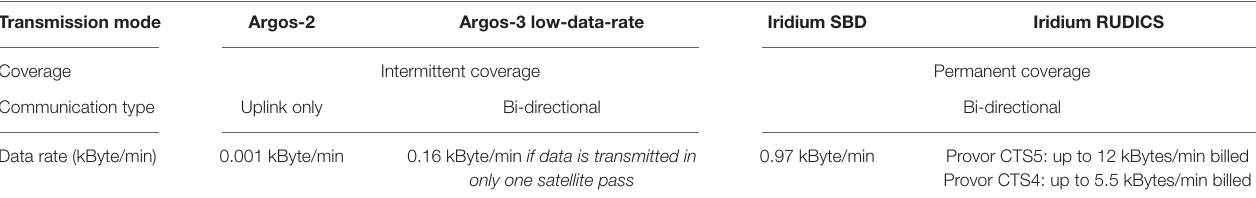
FIGURE 12 | Survival rate of the main Argo profiling floats. After 1,000 days at sea, 98% of the SOLO 2, 96% of the Arvor, 93% of the NAVIS_EBR and S2A, and 89% of the APEX are still in operation at sea. The float-sample criteria comprised their status (active, operational, or closed), deployment date (since January 1, 2016), and cycle period (240 h or 10 days). Source: www.jcommops.org, September 23, 2020. TABLE 2 | Comparison between Argos-2, Argos-3 low-data-rate, Iridium SBD and Iridium RUDICS modes, and data rates obtained on Arvor, Deep-Arvor and Provor CTS4/CTS5 profiling floats at